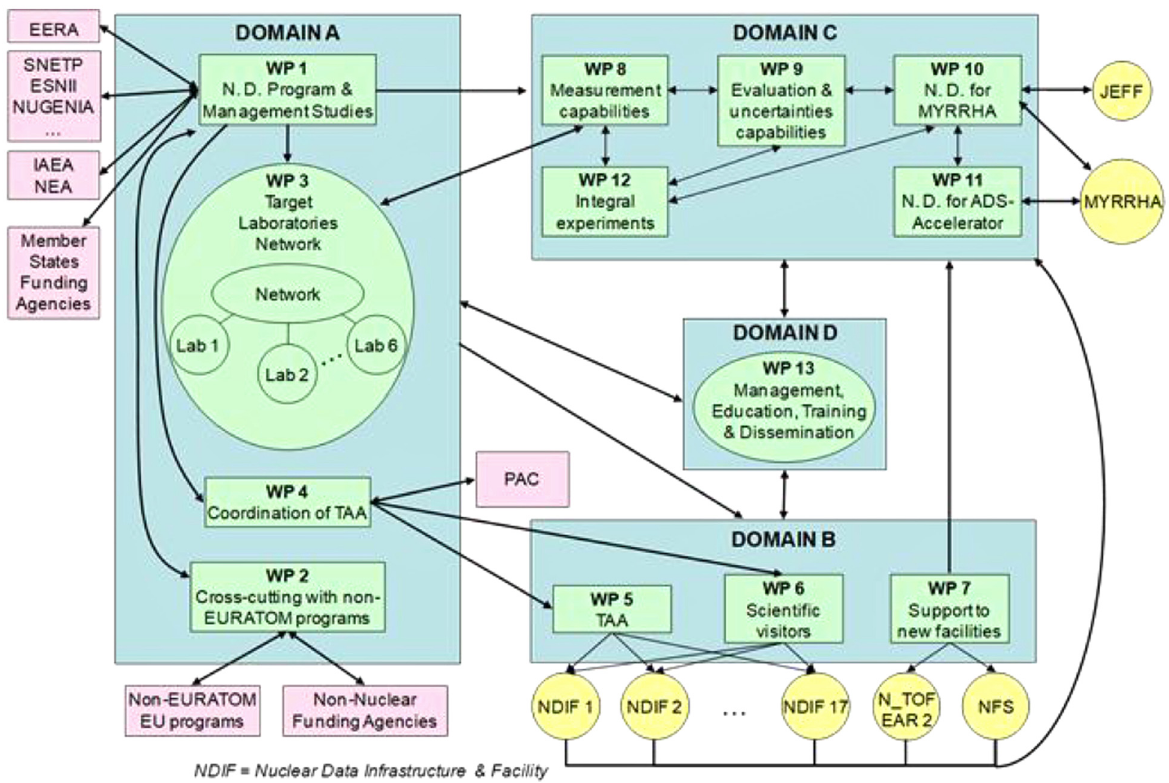
Fig. 1. CHANDA structure of activities and external